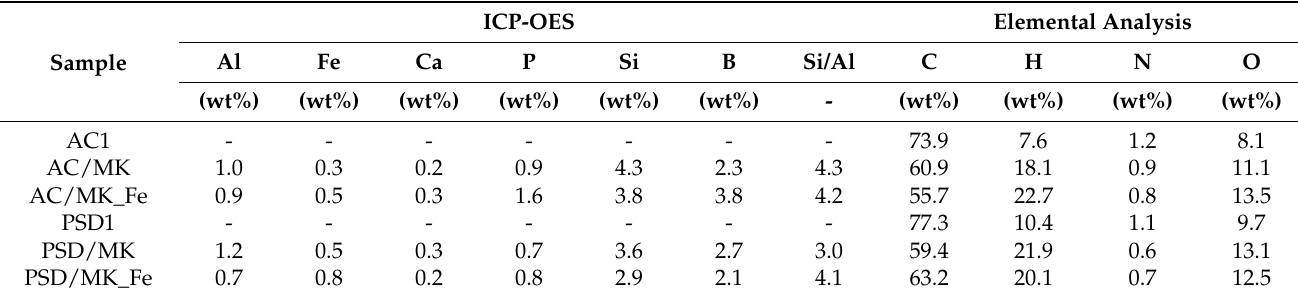
Table 2. Elemental analysis of the samples.